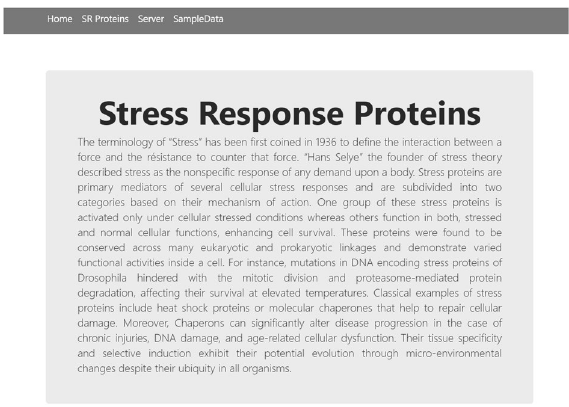
Figure 15. Introduction page of web-server.